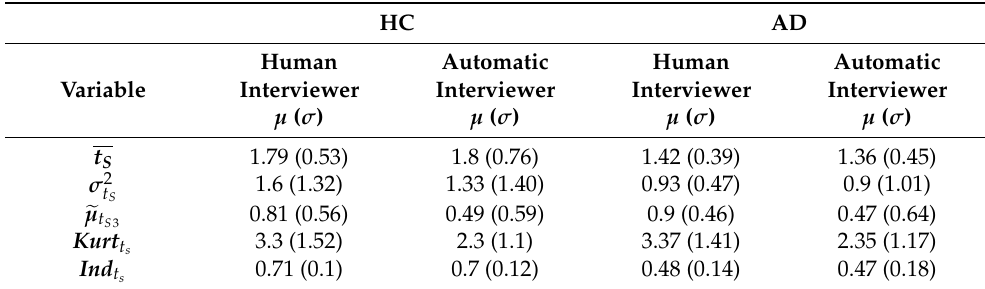
Table 3. Descriptive statistical results: mean values ( µ ) and standard deviation ( σ ). HC AD Variable